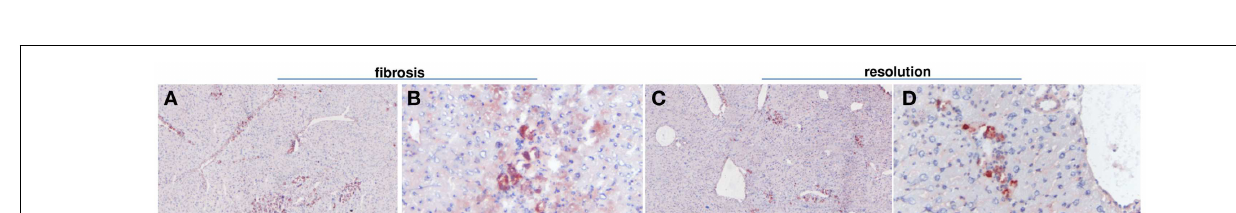
FIGURE 9 | Immunohistochemical and western blot analysis of the hepatic expressions of collagen type I (A–C) and macrophages [CD68 (D–H)] in fibrosis [4weeks of CCl4 in mice (A,D,G)] and in livers